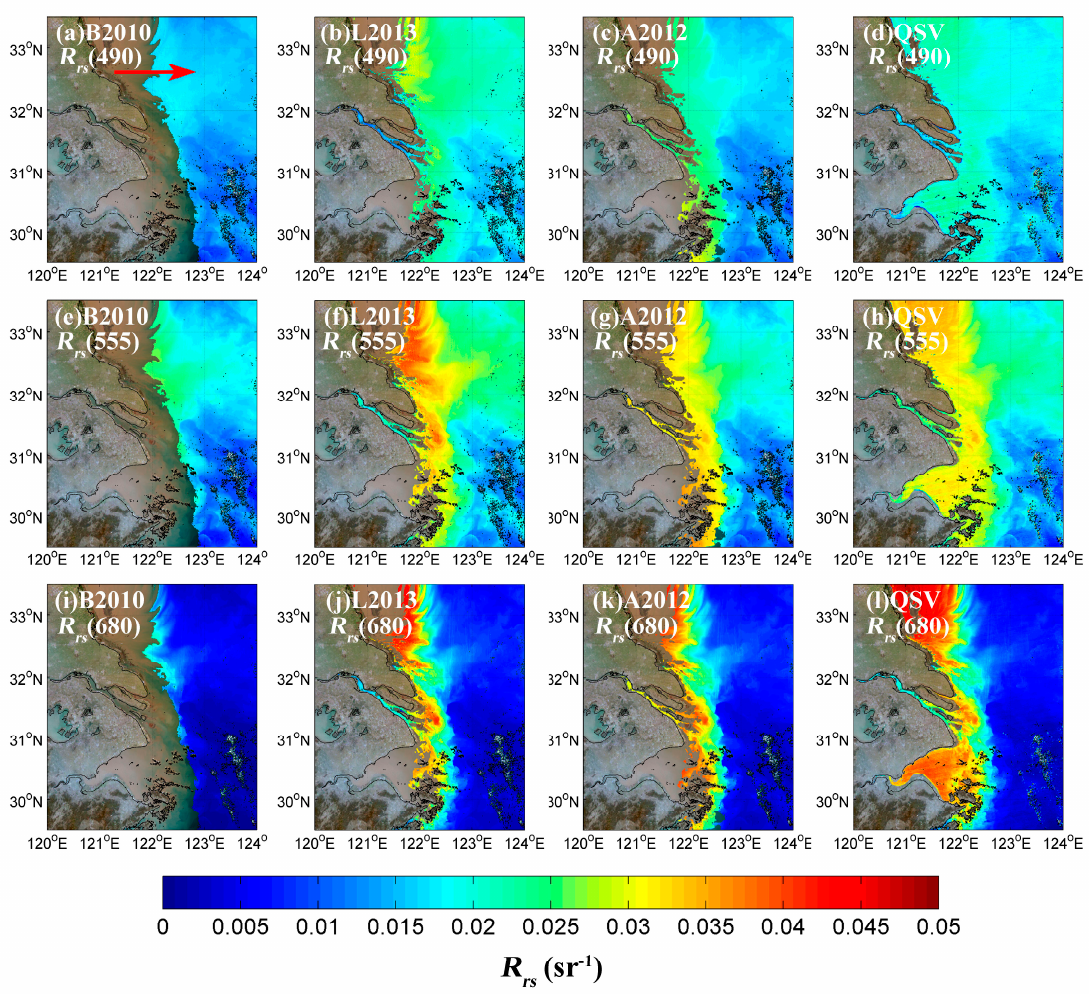
Figure 4. Comparisons of the R rs distributions (unit: sr − 1 ) at ( a – d ) 490, ( e – h ) 555, and ( i – l ) 680 nm bands centered on the Changjiang Estuary on 1 March 2016 and processed by the B2010, L2013, A2012, and QSV algorithms. The red arrow in panel ( a ) refers to the location and direction of the transect used in Figure 5. The regions in which the algorithms fail to make an AC because of highly turbid waters, or the presence of clouds and land are shown by the composed RGB pictures (B: 490 nm, G: 555 nm, and R: 680 nm).